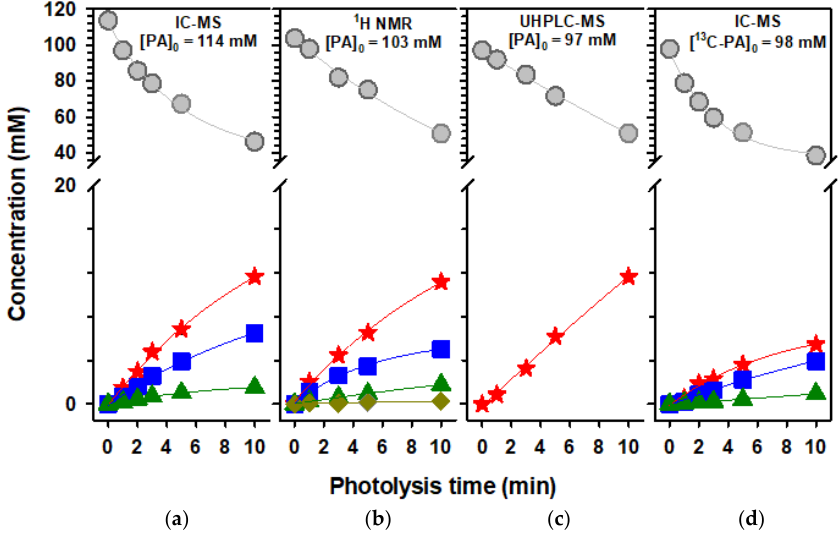
Figure 6. Quantitative time series for the aqueous photolysis at λ ≥ 305 nm of (gray circle) PA with the formation of (red star) the oxo-C7 product, (blue square) DMTA, (green triangle) the oxo-C8 product, and (gold diamond) acetic acid. The analytical method and initial concentration of PA are summarized at the top of each panel. ( a ) Ion chromatography (IC) with conductivity and mass